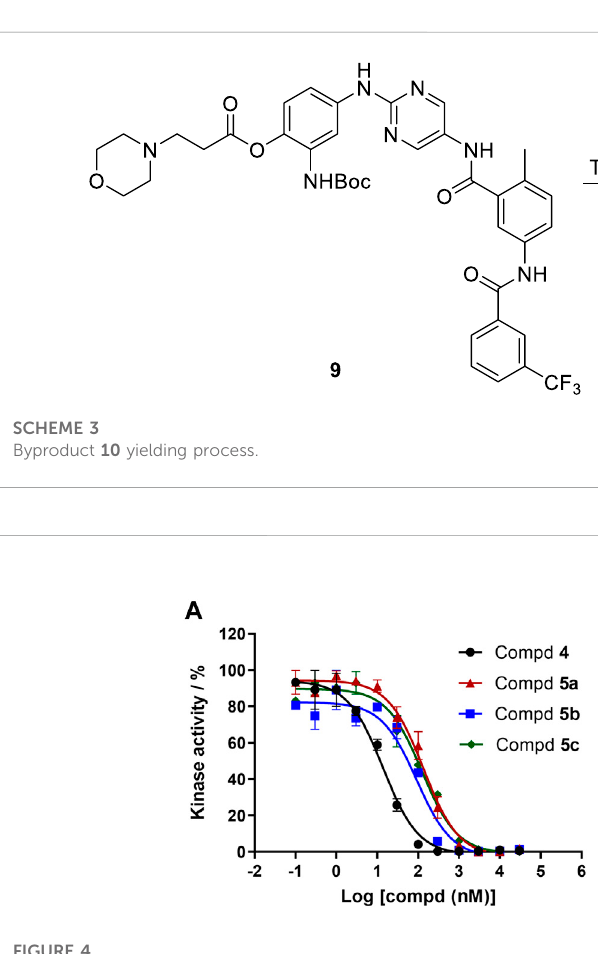
FIGURE 4 (A) Enzymatic activities of parent 4 and prodrugs 5a-c for BTK. Kinase enzymology assays were carried out in accordance with the protocols described in the HTRF KinEase assays. (B) Time-dependent plasma stability assay.